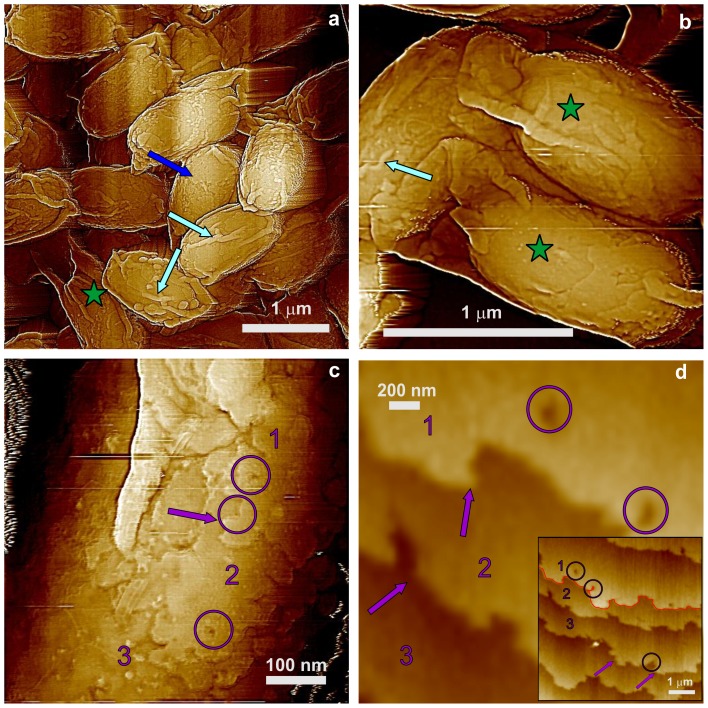
AFM images of cotE spores.(a,b) Height images of spores that exhibit surface ridges (light blue arrows), and several spores with an oversize sacculus are labeled with green stars. In (a) a spore with no apparent ridges is indicated with a dark blue arrow. (c) Height image of a multilayer inner coat structure. Three layers are indicated with numbers, and a kink on a step edge is marked with a purple arrow. Several holes in the layered structure are also indicated with purple circles. The hole in the middle circle corresponds to a pinning point on the step. (d) Height image of a multilayer layer structure similar to ones seen in Figs. 5b,c, 6c, and 7c, as seen on the surface of a trypsin crystal. Similar to the spore coat layers in (c), three layers, kinks and several holes are indicated with purple numbers, arrows and circles, respectively. The insert in (d) is a larger area of the crystal surface seen in (d). The same holes and three layers seen in (d) are indicated in the insert. The red line in (d) denotes the step contour, which was utilized for the measurement of the sinuosity index. Panel (d) is reprinted with permission from Plomp M, McPherson A, Larson SB, Malkin AJ (2001). Growth mechanisms and kinetics of trypsin crystallization. J Phys Chem B 105: 542–551. [52]. © (2001) American Chemical Society.